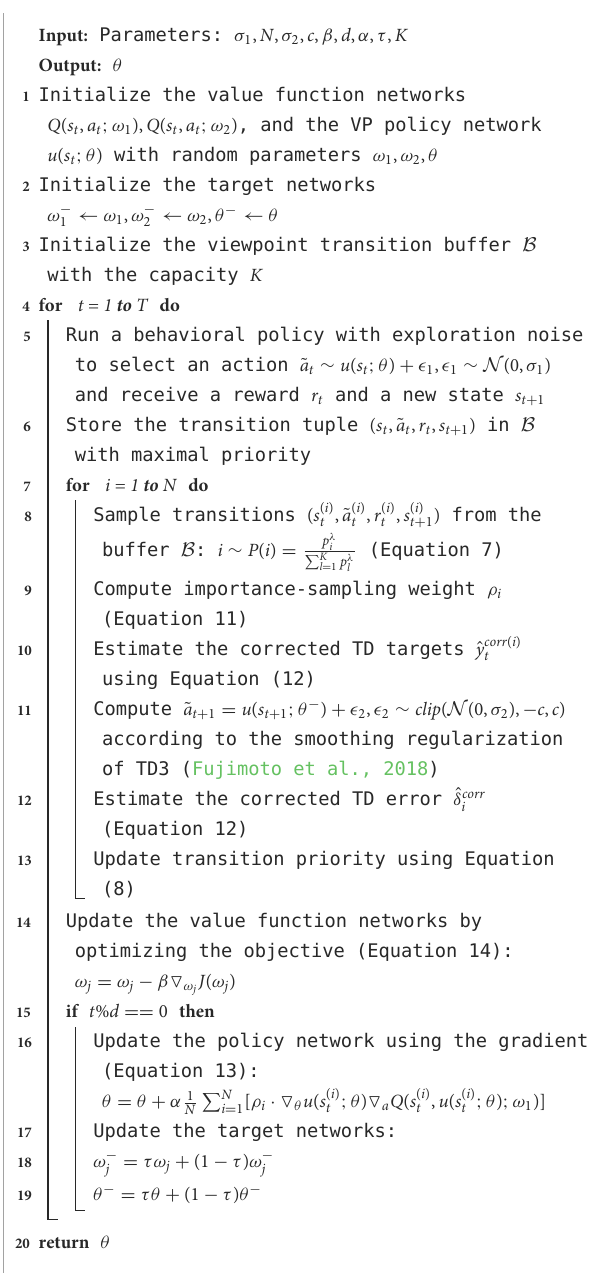
Algorithm 1. Training the deterministic continuous VP policy